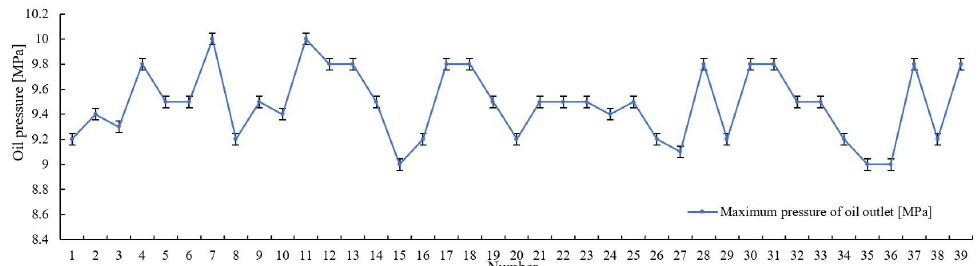
Figure 12. Oil discharge pressure of the grease suction and drainer devices after 12,000 fatigue tests.